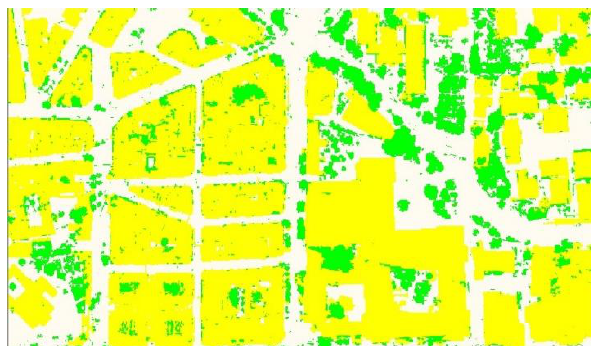
Figure 6. Buildings (yellow), vegetation (green) and ground area (white) classification based on the OBIA